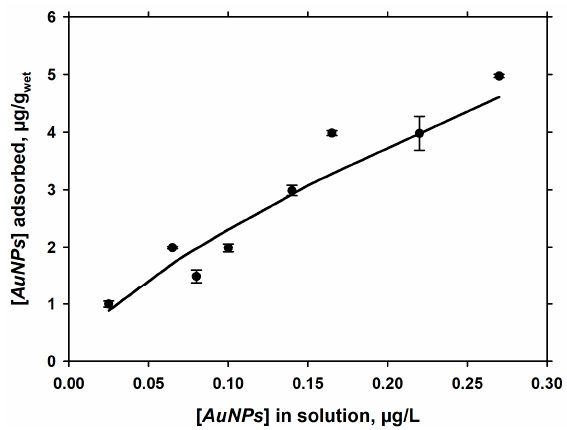
Figure 8. Low–range adsorption of AuNPs onto EOMI diatoms: concentration of adsorbed AuNPs at the surface of EOMI cells after 2 h mixing in 5 mM NaCl + 5 mM NaHCO 3 at pH = 8.50 ± 0.05. The solid line is a fit to the data using the Freundlich isotherm. Table 3. Freundlich isotherm parameters for the adsorption of AuNPs on EOMI diatom as a function of AuNPs in solution. Dry biomass was always 10 g wet /L.